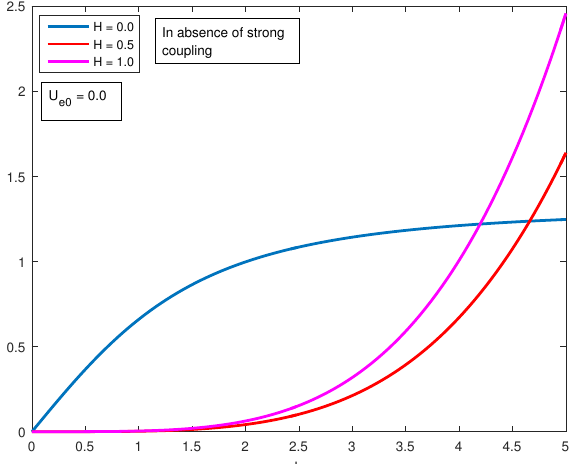
Figure 1. The plot of the dispersion relation in the absence of strong coupling and electron stream- ing velocity.